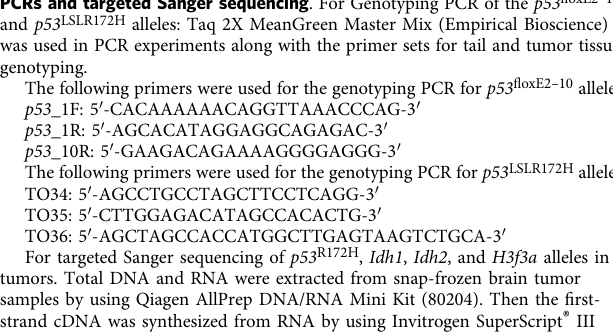
Fig. 7 Olig2 + progenitors with Erk/MAPK activation underlie clonal expansion in the SVZ. a Copy-number variations (CNVs) of Nf1 gene were shown in the three Type 2 cases. Blue represents copy loss/deletion, while red represents copy gain/ampli fi cation. b Western blotting of cell lines from the samples described above showed Nf1 protein levels. Red arrow indicates the histologically normal Mouse 6 SVZ R : a control with normal levels of Nf1 expression. Source data are provided as a Source data fi le. c – i Control ( n = 6), p53 R172H CKO ( n = 3) and p53 Δ E5 – 6 CKO (n = 14) mice at age 5 – 7 months were injected with BrdU to detect proliferating cells in tumor-free brains. White dashed lines in ( c , e , f ) mark the areas of SVZ and/or RMS in the stem-cell niche. c , d Co-labeling of p-Erk and BrdU in the SVZ. Arrows indicate p-Erk + BrdU + cells (yellow), only observed in the mutant. Arrowheads indicate p-Erk + BrdU − cells (green), observed in the control. Insets show high magni fi cation in the SVZ. Quanti fi cations are shown in ( d ). e Co-labeling of: p-Erk and BrdU; BrdU and p 53 in early glioma-like clusters. Arrows indicate p-Erk + BrdU + , p53 R172H BrdU + , or p53 Δ E5 – 6 BrdU + cells. Arrowheads indicate p-Erk + BrdU − cells. f Co-labeling of Olig2 and BrdU in the SVZ (left) and early glioma-like clusters (right). Arrows indicate Olig2 + BrdU + cells. g – i Co-labeling of p-Erk/Olig2 low- (left) and high- (middle, boxed areas in left) magni fi cation, and p53/Olig2 (right) in the SVZ ( g ); early glioma-like cluster ( h ). Arrows indicate p-Erk + Olig2 + or p53 Δ E5 – 6 Olig2 + cells. Arrowheads indicate p-Erk + Olig2 − cells. The quanti fi cation of p-Erk + Olig2 + cells is shown in ( i ). j Representative early glioma-like clusters in the olfactory bulb from p53 Δ E5 – 6 CKO brains ( n = 7) were labeled with: p-Erk; p53/Ascl1; p53/Ezh2; and Olig2/BLBP. Arrows indicate p53 Δ E5 – 6 Ascl1 + or p53 Δ E5 – 6 Ezh2 + or Olig2 + BLBP + cells. Data are presented as a dot plot with mean±SEM. Unpaired, two-tailed Student ’ s t test was used for statistical analysis in ( d , i ). ** p <0.01, *** p <0.001. SVZ subventricular zone, LV lateral ventricle, OB olfactory bulb, RMS rostral migratory stream, CC corpus callosum, SE short exposure, LE long exposure. DAPI is a nuclear counterstain. Scale bars: 50 µ